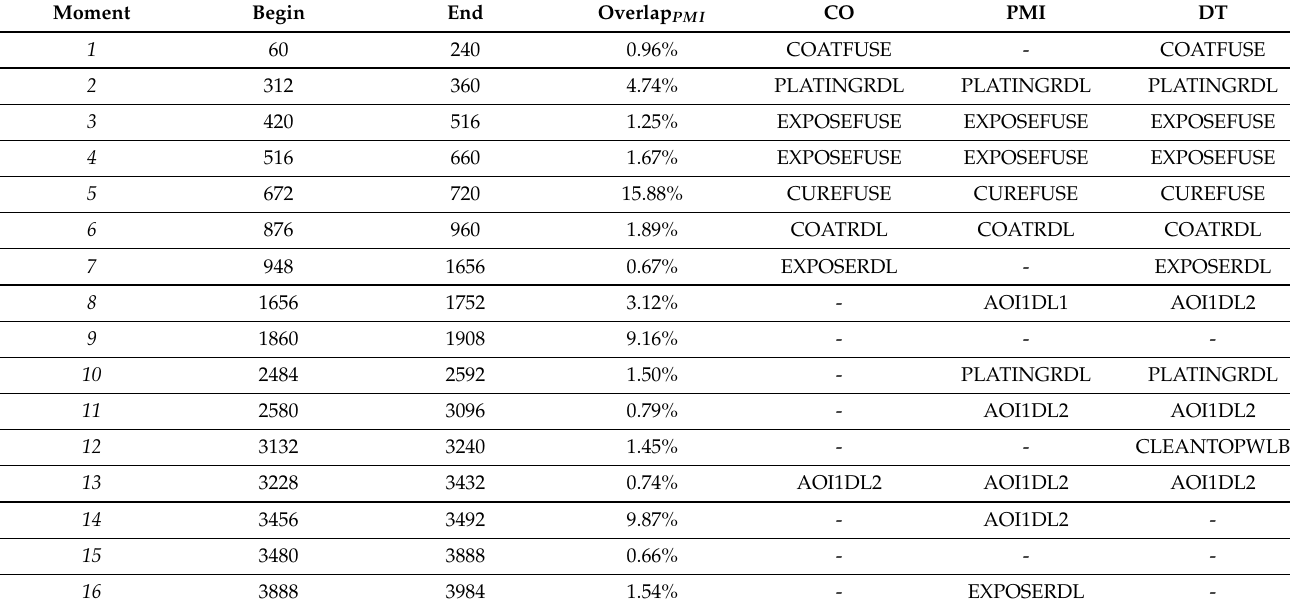
Table 6. Table summarizing the problematic moments identified in the case study dataset, as well as the common root causes among the different algorithms